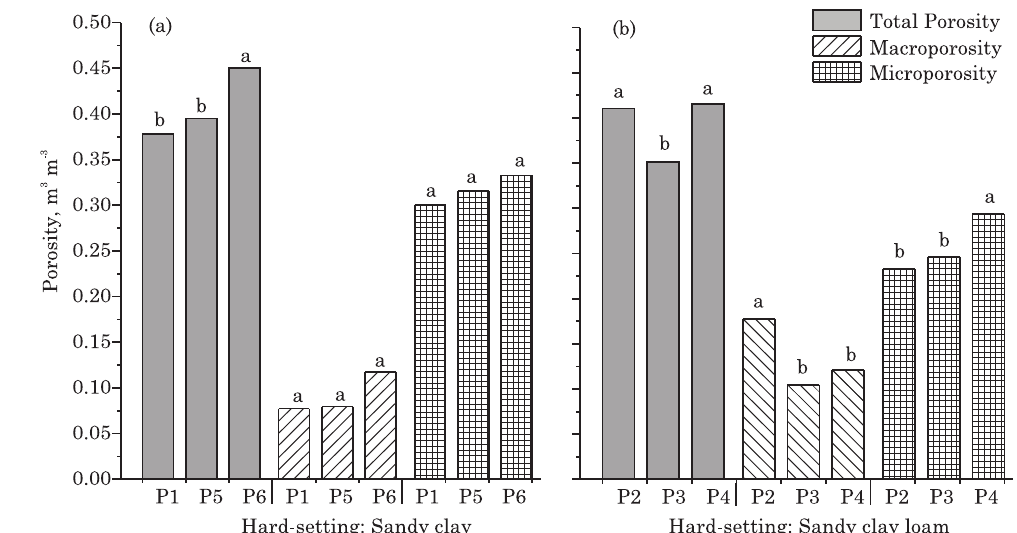
Figure 3. Macroporosity, microporosity and total porosity of hard-setting soils with sandy clay (a) and sandy clay loam (b) textures. Means followed by the same letter do not differ significantly from one another (p=0.05). P1: Camocim (CE), P2: Parazinho (CE), P3: Pacajus (CE), P4: Cruz das Almas (BA), P5: Aracruz (ES), and P6: Campos dos Goytacazes